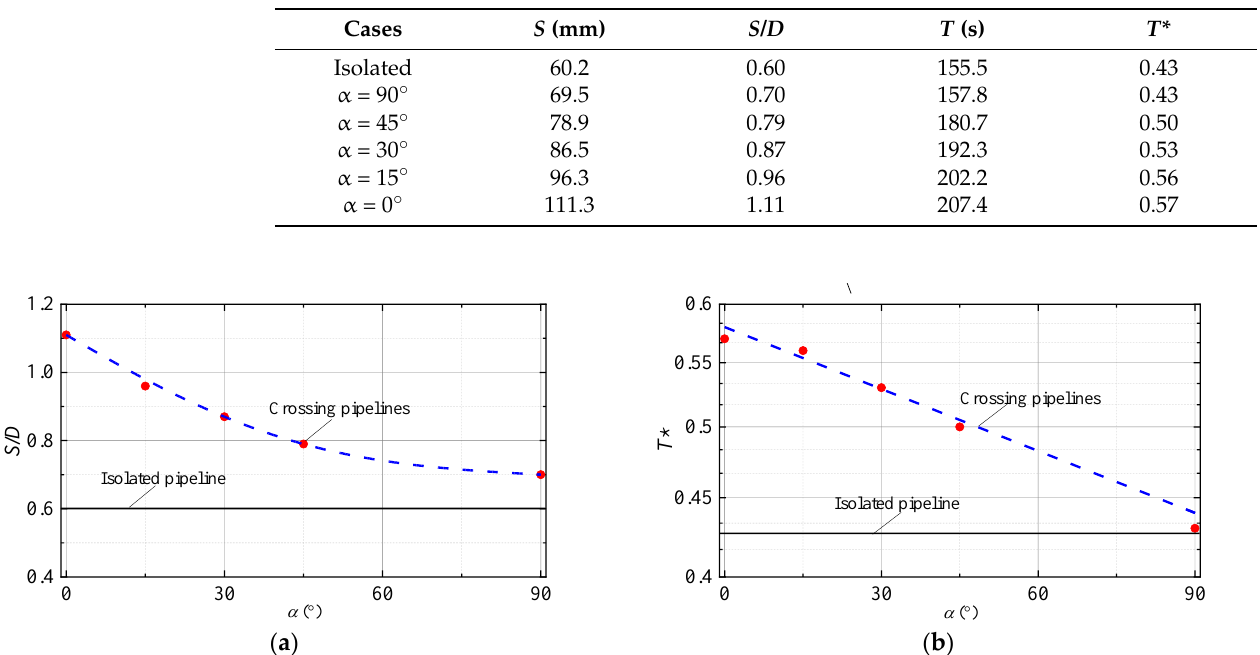
Table 4. Equilibrium depth and time scale of scour for different intersecting angles.